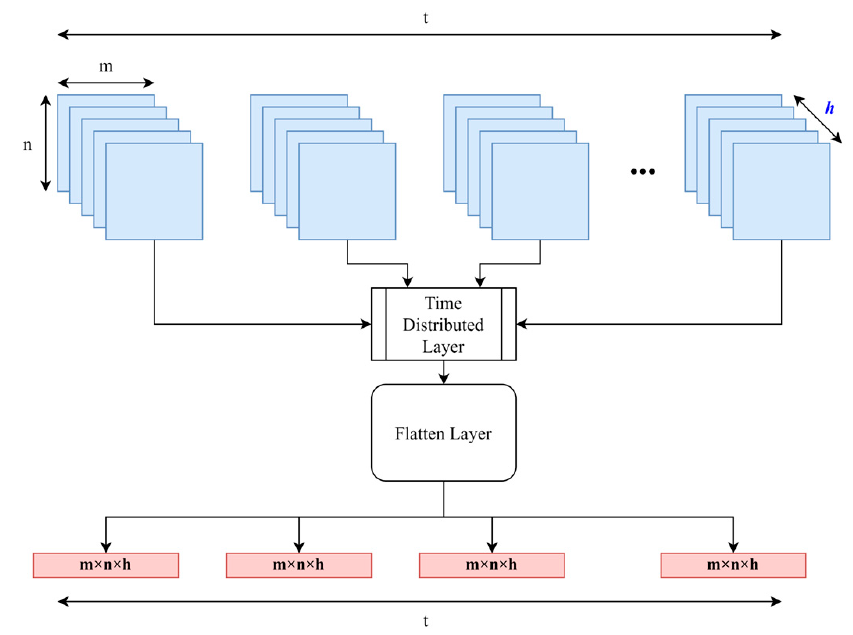
Figure 6. Description of time distributed function, specialized for keeping the order in data.